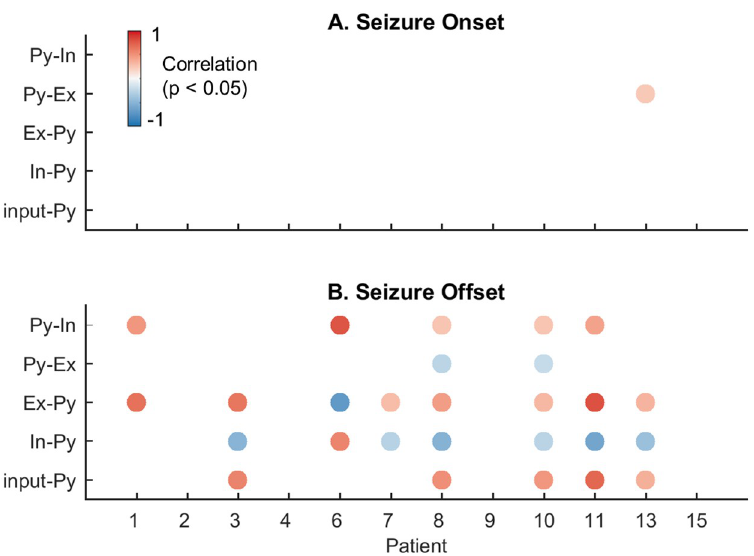
Fig 6. Correlation between connectivity and seizure duration. Correlation was measured between seizure duration and average connectivity strength (averaged across electrode channels) taken 5s before seizure onset (Panel A), and 5s before seizure offset (Panel B). Only significant correlation values are shown ( p < 0.05). A Bonferroni correction for multiple comparisons was performed before computing significance, where the 0.05 significance level was divided by 60 (12 patients and 5